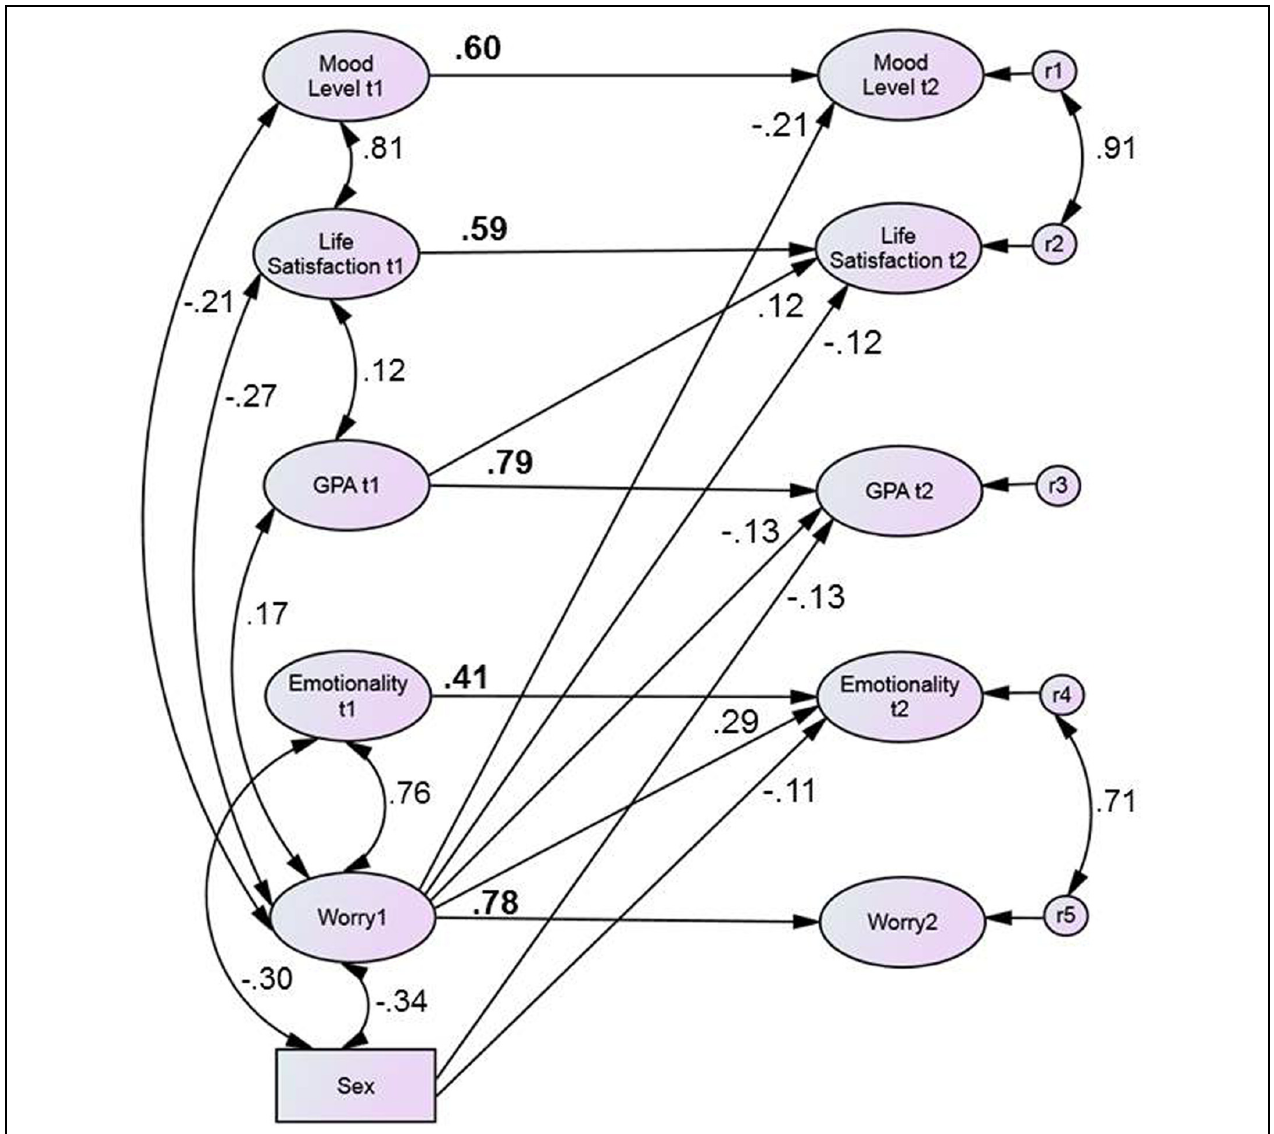
FIGURE 1 | SEM incorporating all constructs controlling for each other. Only significant paths and correlations ( p < 0.05) were considered. Numbers in bold represent stability